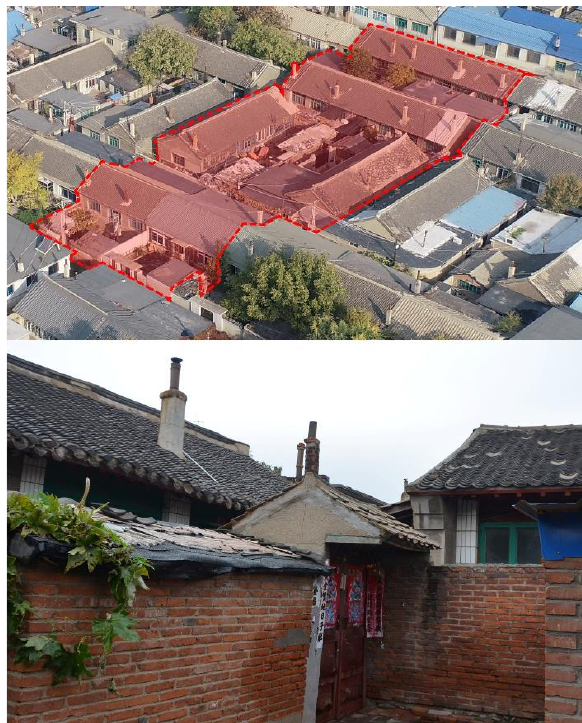
Figure 6. Messy courtyard in the old town of Gaizhou. Photo by Xing Zhenpeng, 2019.